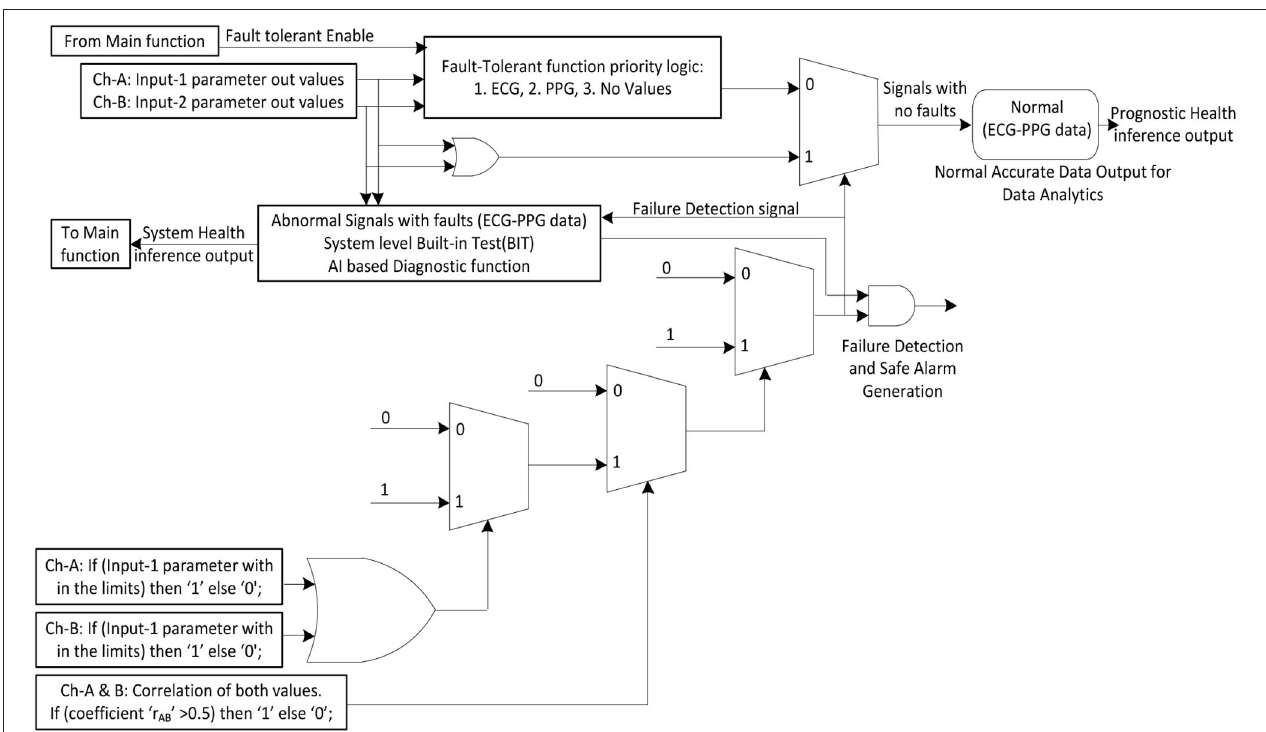
FIGURE 2 | 2oo2 fault detection and fault-tolerant logic